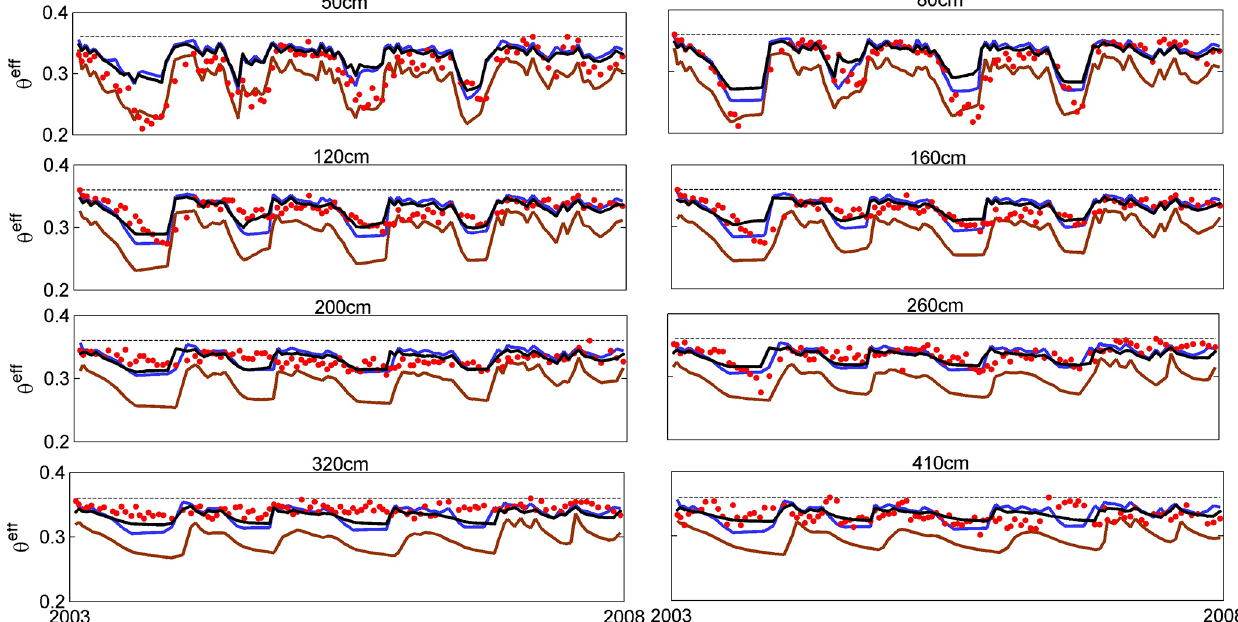
Figure 2. Comparison of the optimized effective soil moisture ( θ eff ) time series with the observed soil moisture (red dots) at various depths at Warren Farm, Berkshire, UK. Brown lines show soil moisture estimated by JULES + WG + PDM; blue lines show soil moisture estimated by JULES + WG + PDM + CHALK; and black lines show soil moisture estimated by JULES + WG + PDM + CHALK + GW. Grey horizontal line shows the effective soil moisture at saturation 0.36. Note, only a representative subset of soil moisture time series utilized in the analysis is shown in the